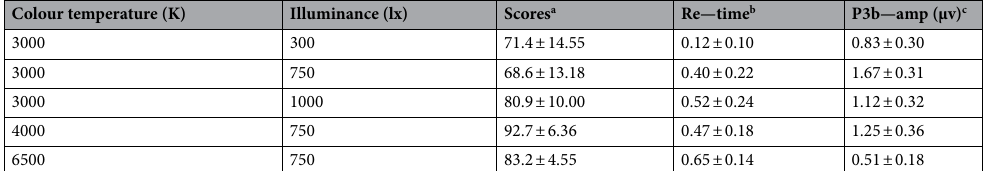
Table 1. An example of means ± SD from physiological and psychological response analysis under different lighting conditions. a NASA-TLX scores as psychological response; lower scores predicted lower mental workload. b The min–max–normalized response time; shorter re-time predicted lower mental workload. c P3b amplitude of the P4 electrode; higher P3b – amp predicted lower mental